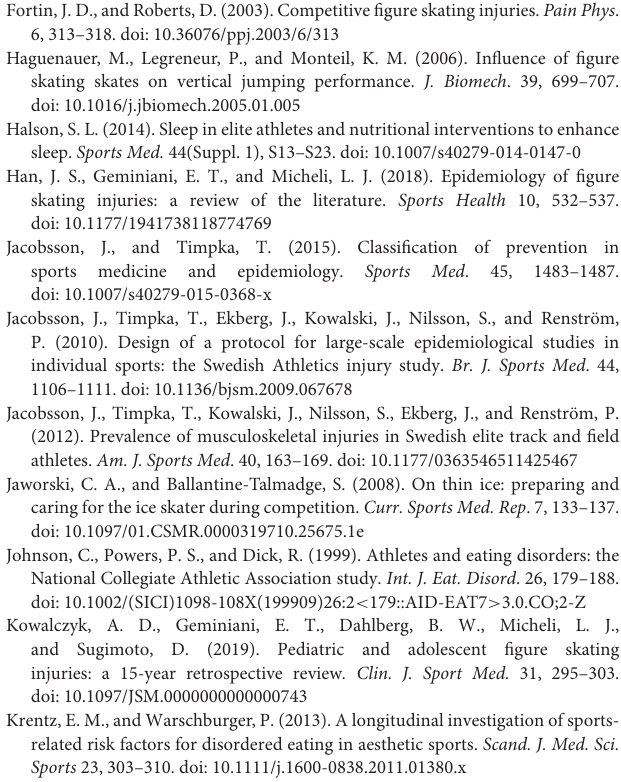
Swedish Figure Skating Association (2018). Konståkningen Vill (November 2018). Available online at: https://www.svenskkonstakning.se/globalassets/svenska- konstakningsforbundet/dokument/om-oss2/rad-och-stod/konstakningen- vill_2018-2019.pdf (accessed October 13, 2019). Swedish Figure Skating Association (2020). Elitserien och Morgondagarserien 2018-2019. Available online at: